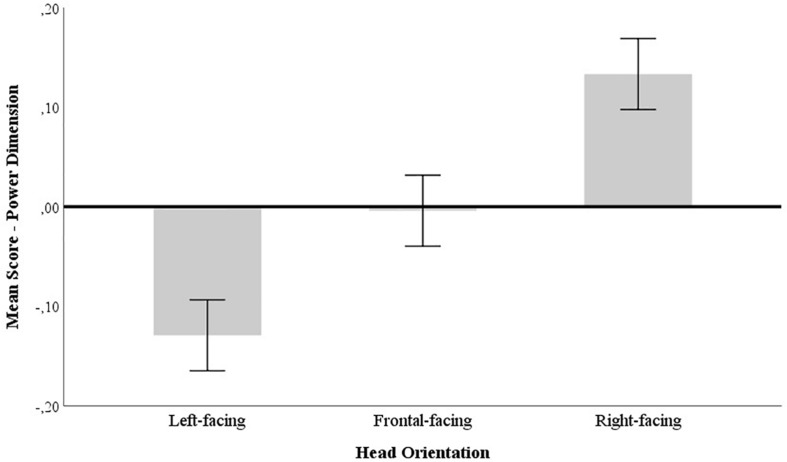
Mean differences for left, front, and right head orientations in the Power scale. Error bars represent the 95% confidence interval.